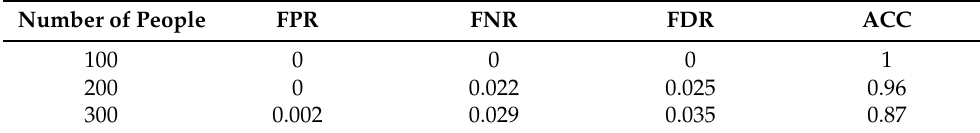
Table 3. Performance analysis based on number of patients. Number of